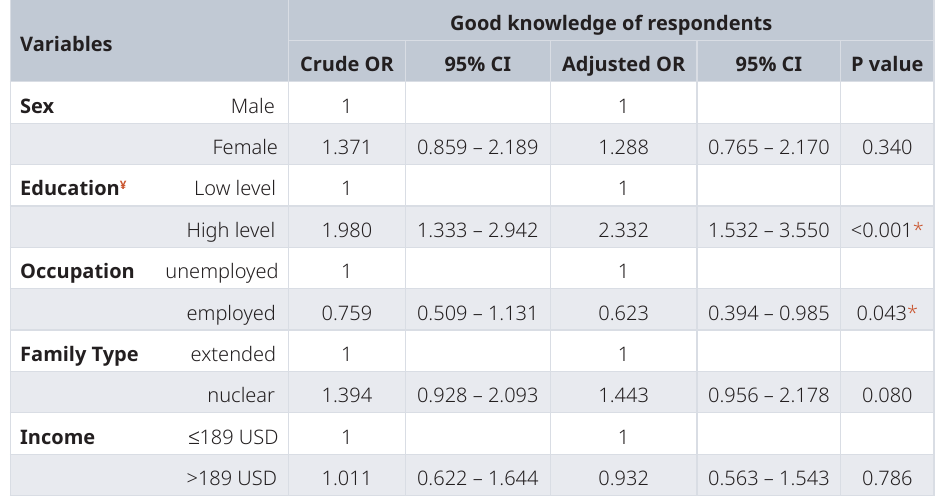
Table 3. Factors associated with good knowledge ( ≥ 7 score) of JE among respondents in Yangon region, Myanmar